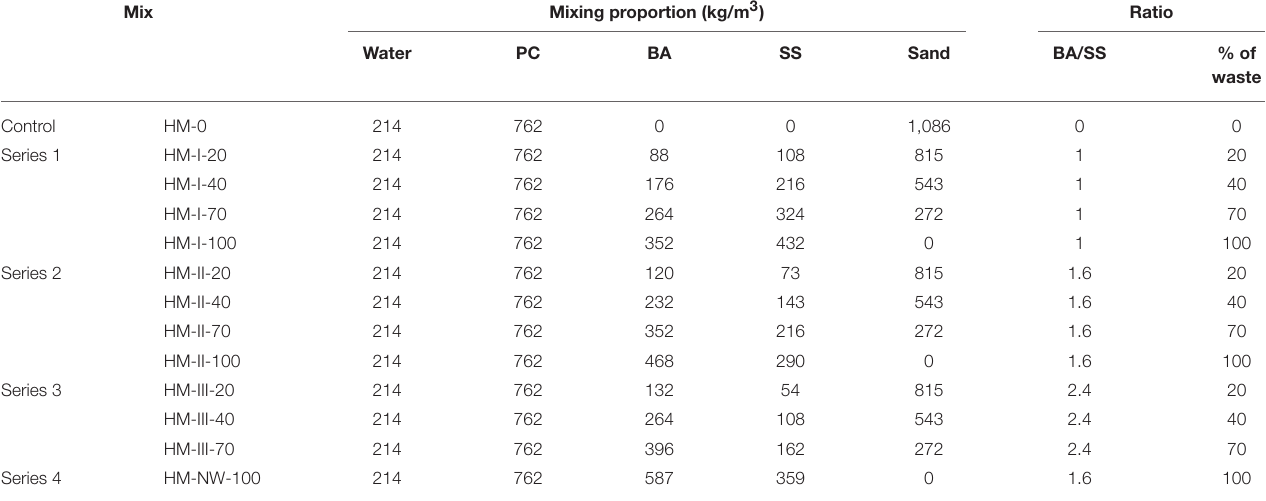
TABLE 1 | Mixing proportion used in the Part one study a .